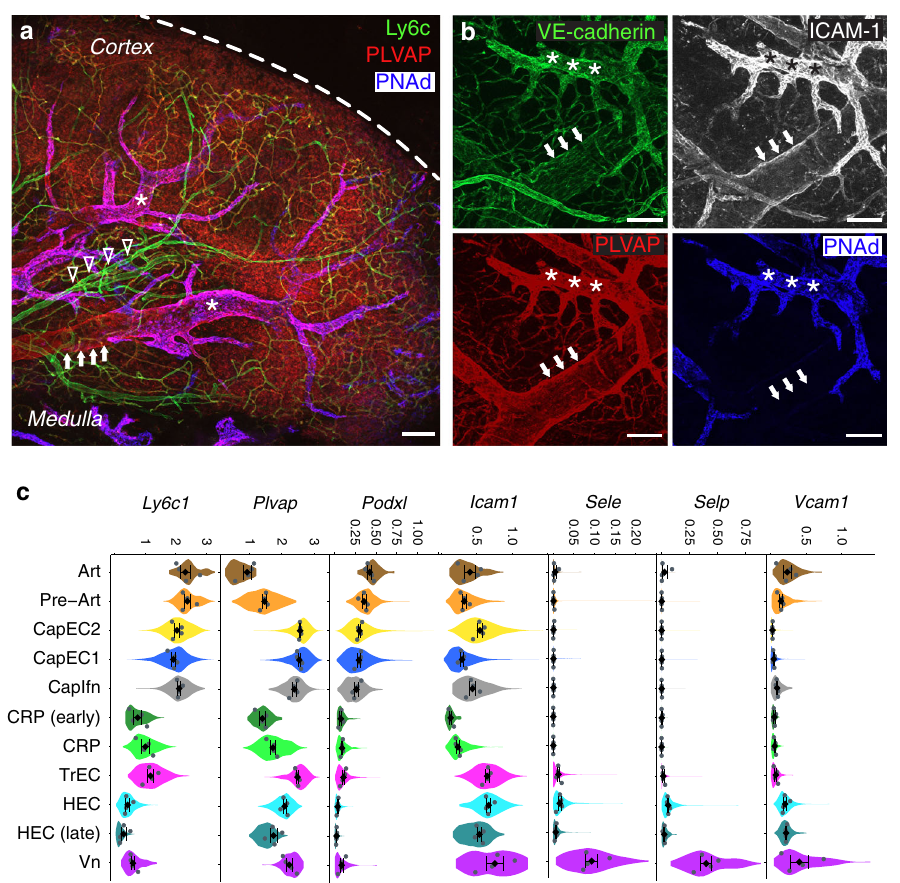
Fig. 2 Marker gene expression and immunolocalization of the major arterial and venous populations. Immuno fl uorescent visualization of PLN vessels using intravenously (i.v.) injected antibodies: anti-Ly6c (green), anti-PLVAP (red), and anti-PNAd (blue). Dashed line, lymph node capsule ( a ); anti-VE- cadherin (green), anti-ICAM-1 (white), anti-PLVAP (red), and anti-PNAd (blue) ( b ). Arrow heads, artery (Ly6c + PNAd − , PLVAP − , ICAM1 low ). Arrows, medullary veins (PNAd − , ICAM1 + , PLVAP + , Ly6c − ). Medullary veins are downstream of HEC. Asterisks, HEV (PNAd + ). Bars, 100 μ m. Dotted line, medullary vein. Images representative of three independent experiments. c Violin plots showing expression of genes Ly6c1 , Plvap , Podxl , and Icam1 corresponding to immuno-stained marker proteins; and Sele , Selp and Vcam1 illustrating selective expression by non-HEV vein. Note the decline in Podxl expression from artery to pre-Art to capillary EC subsets, and a corresponding decline in intensity of staining for Ly6c1 as arteries bifurcate into capillaries in situ in a . Mean expression values for each of the four independent cohorts (grey dots) and mean and SEM of the cohort means are also plotted (black diamonds) within the violin